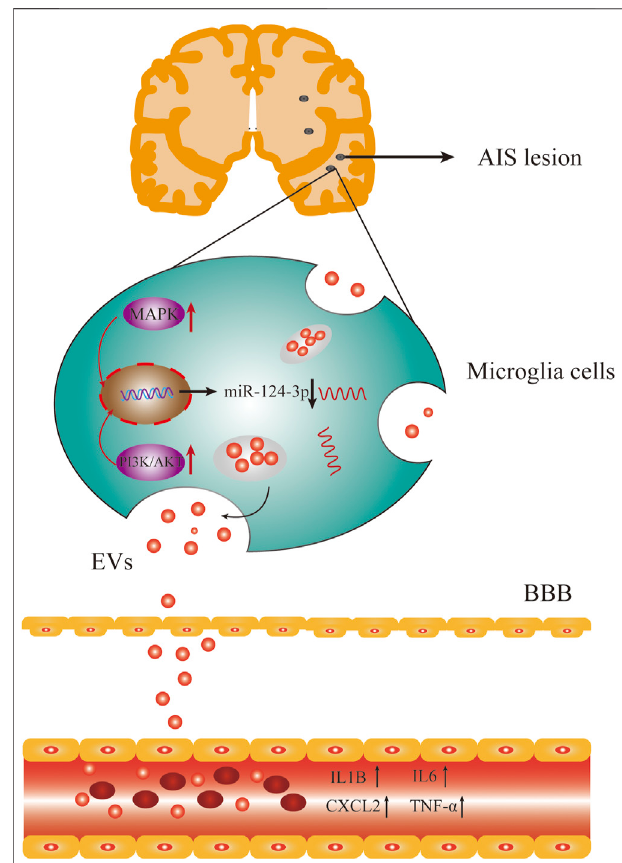
FIGURE 8 | AIS activated the pro-in fl ammatory signaling pathways and inhibited the expression of miR-124-3p , which also upregulated the expression of pro-in fl ammatory factors in